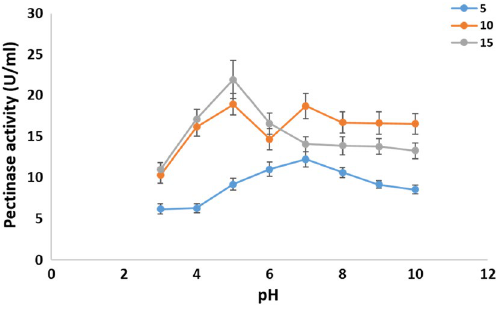
Figure 9. Effect of pH at 5, 10, and 15 °C on the pectinase production by Cladosporium compactisporum AUMC 11366.